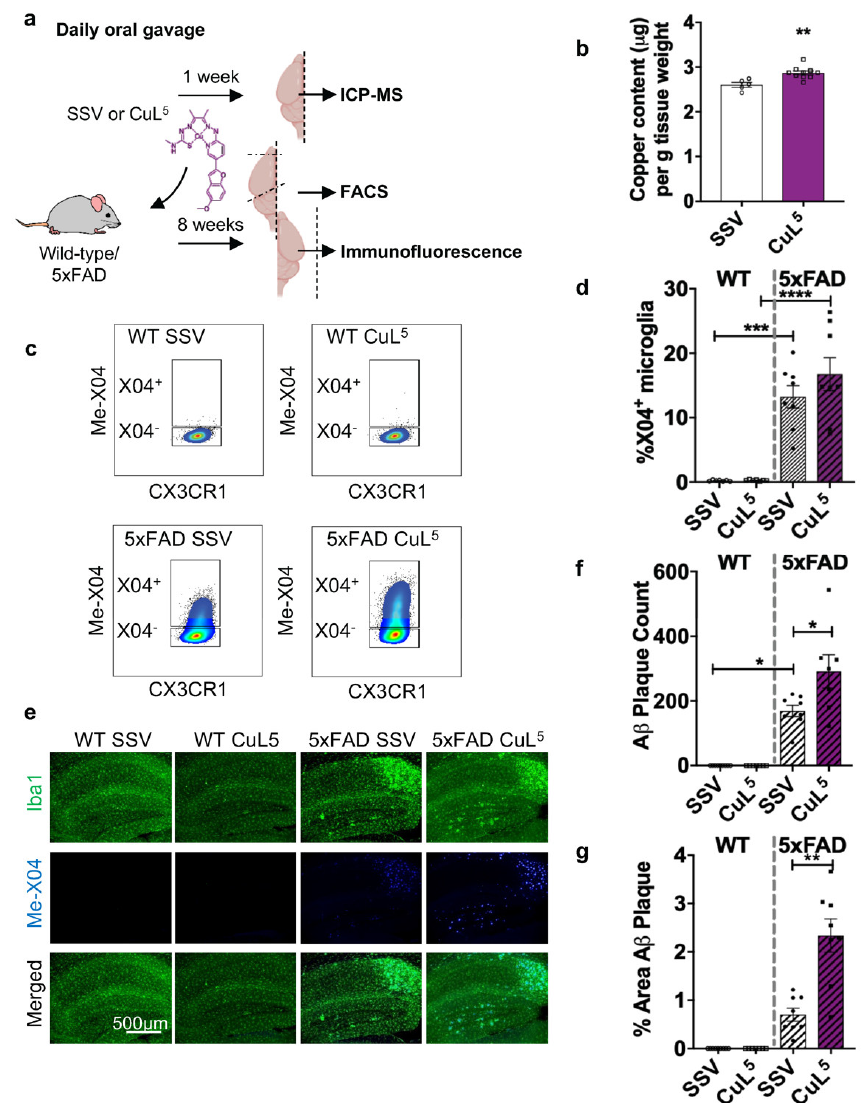
Figure 4. CuL 5 treatment increased microglial phagocytosis and A β load in 5xFAD mice. ( a ) Illustration of experimental workflow, created with BioRender.com. SSV or CuL 5 (30 mg/kg) were delivered to non-transgenic (WT) or 5xFAD mice by oral gavage, once daily, for 1 or 8 weeks. ( b ) Brain samples collected from a mixed cohort of WT ( n = 10) and 5xFAD ( n = 5) animals treated for 1 week were analysed for copper content by ICP–MS ( n = 5–10 per treatment group). Individual mice treated for 8 weeks were injected with Methoxy-X04 prior to the collection of brain samples for ( c , d ) ex vivo isolation of microglia and analysed for the proportion of X04 + and X04 − microglia by FACS ( n = 7–8 per treatment group) and ( e – g ) the analysis of A β plaque load and microgliosis by immunohistochemistry ( n = 7–8 per treatment group). ( b ) Brain copper content measured by ICP–MS is expressed as copper content ( µ g) per g brain tissue. ( c ) Representative FACS plot for microglia sorted from WT and 5xFAD mice, from each treatment group. ( d ) Data obtained are expressed as percentage of X04 + microglia population in total microglia sorted. ( e ) Representative immunofluorescence image of the hippocampus of WT and 5xFAD mice, from each treatment group, injected with Methoxy-X04 and stained for Iba1 (AlexaFluor 488). The ( f ) number of plaques and ( g ) percentage area of plaques in the hippocampal region were determined using ImageJ. ( b , d , f , g ) Data for each treatment group are presented as the mean ± S.E.M per treatment group. Determined by one-way ANOVA, */**/***/**** = p ≤